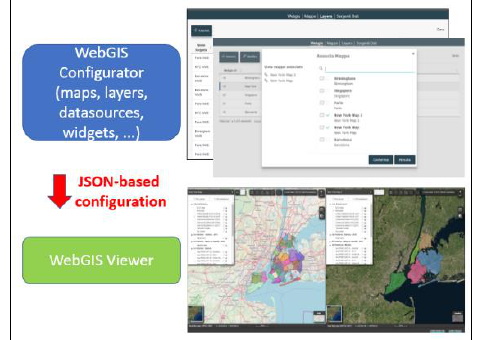
Figure 18. Viewer and Configurator